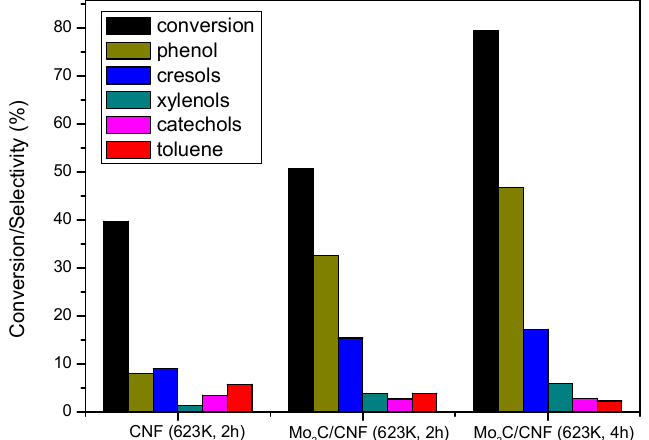
Figure 5. Conversions and product selectivities of the main reaction products during the hydrodeoxygenation of guaiacol at 623 K over the bare CNF support the Mo 2 C/CNF catalyst after 2 band 4 h of reaction.